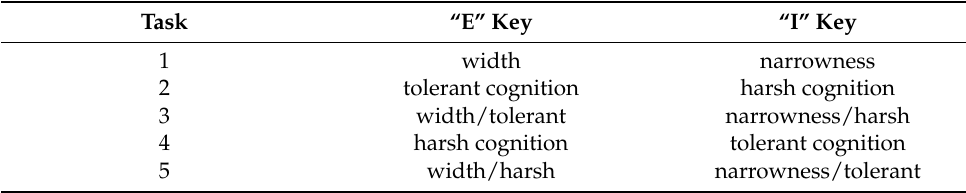
Table 6. The meaning of the keys in different tasks. Task